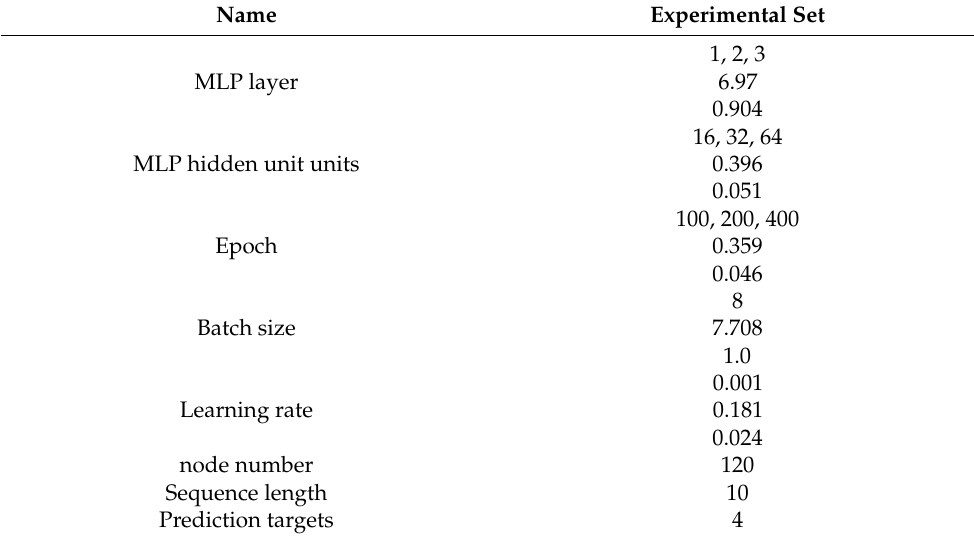
Table A1. Hyper-parameters.